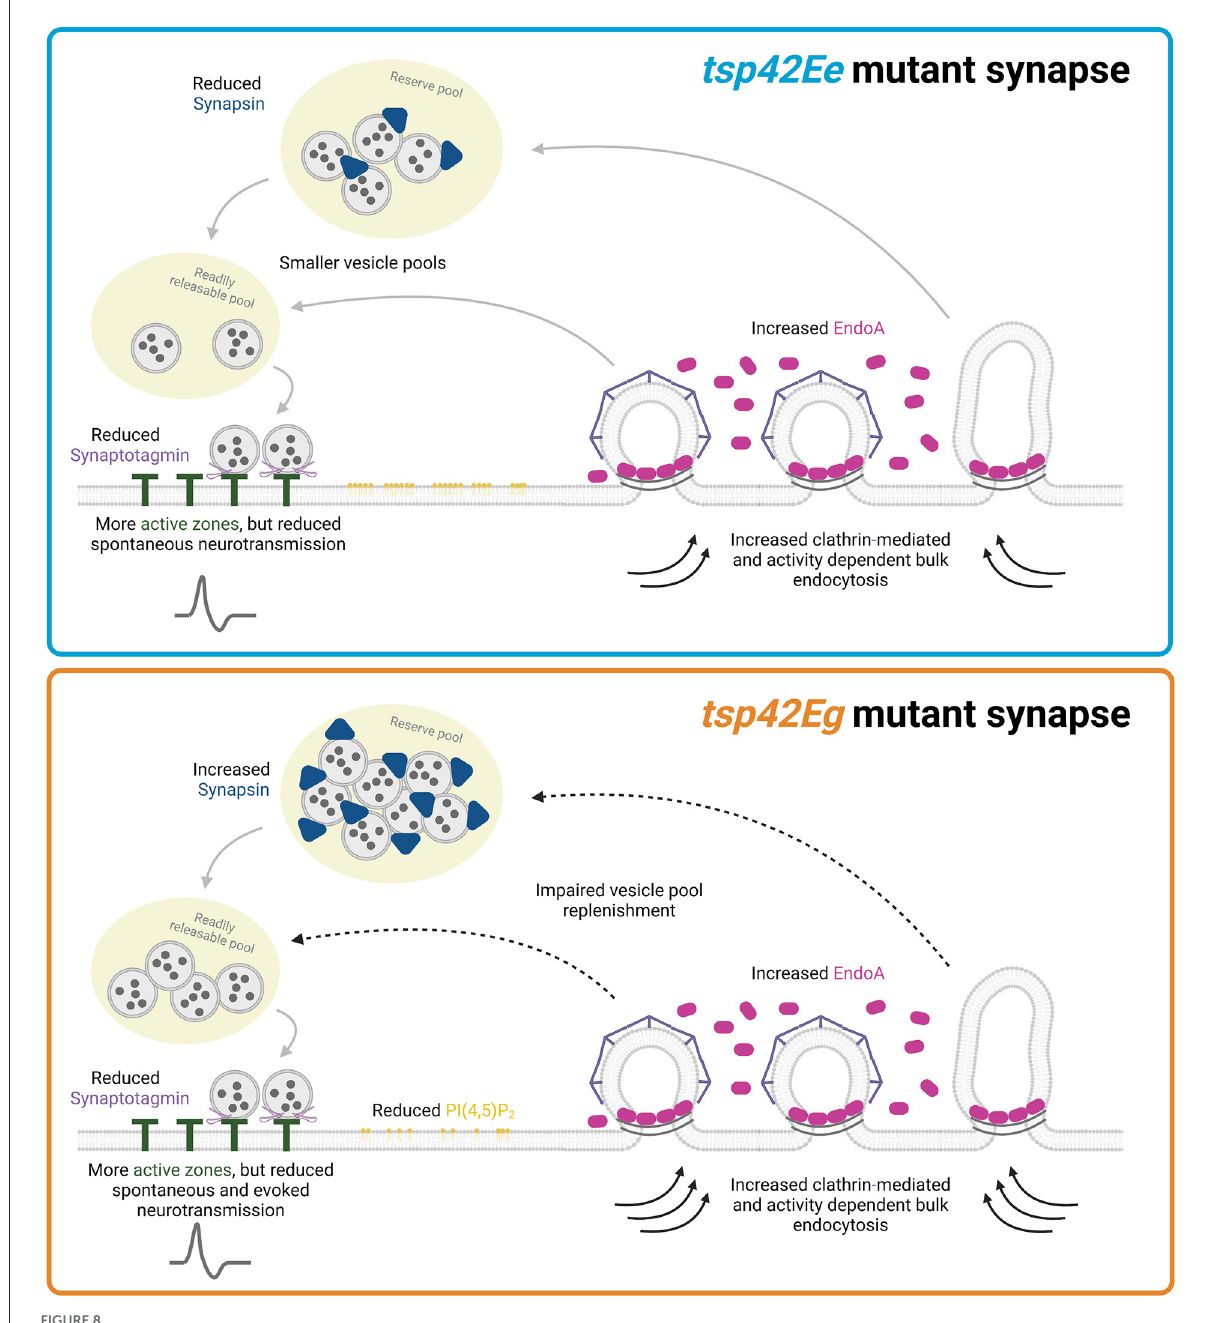
FIGURE8 Tsp42Ee and Tsp42Eg regulate synaptic function through shared and distinct mechanisms. Both Tsp42Ee and Tsp42Eg negatively regulate endocytosis and synaptic localization of the endocytic protein, EndoA. However, Tsp42Ee and Tsp42Eg differentially affect Synapsin and vesicle pool dynamics. Tsp42Ee promotes synaptic localization of Synapsin and is implicated in the maintenance of vesicle pool size and mobilization of vesicles from the reserve pool to the readily releasable pool. Tsp42Eg, however, restricts Synapsin and is necessary for vesicle recycling. Tsp42Eg also distinctly regulates PI(4,5)P 2 localization. Finally, both Tsp42Ee and Tsp42Eg facilitate active zone organization and promote Synaptotagmin localization to active zones. The combined synaptic functions of Tsp42Ee and Tsp42Eg allow for proper neurotransmission as tsp42Ee G 2619 mutants have reduced spontaneous neurotransmission and tsp42Eg MB 08050 mutants have reduced spontaneous and evoked release. Figure created with